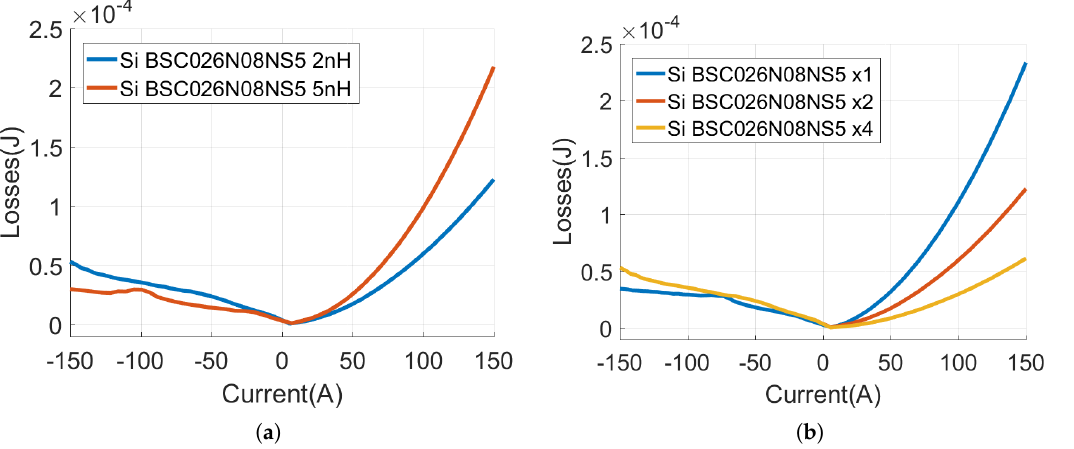
Figure 5. Effect on switching losses where doubling MOSFET in parallel. ( a ) Stray inductance variation effect on switching losses at 28 V switching voltage; ( b ) Doubling MOSFET in parallel effect - BSC026N08NS5 at 28 V switching